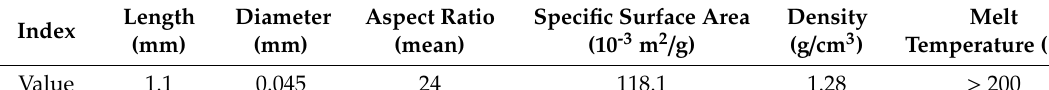
Table 4. Basic Properties of lignin fiber. Table 5. Fundamental characteristics of diatomite.